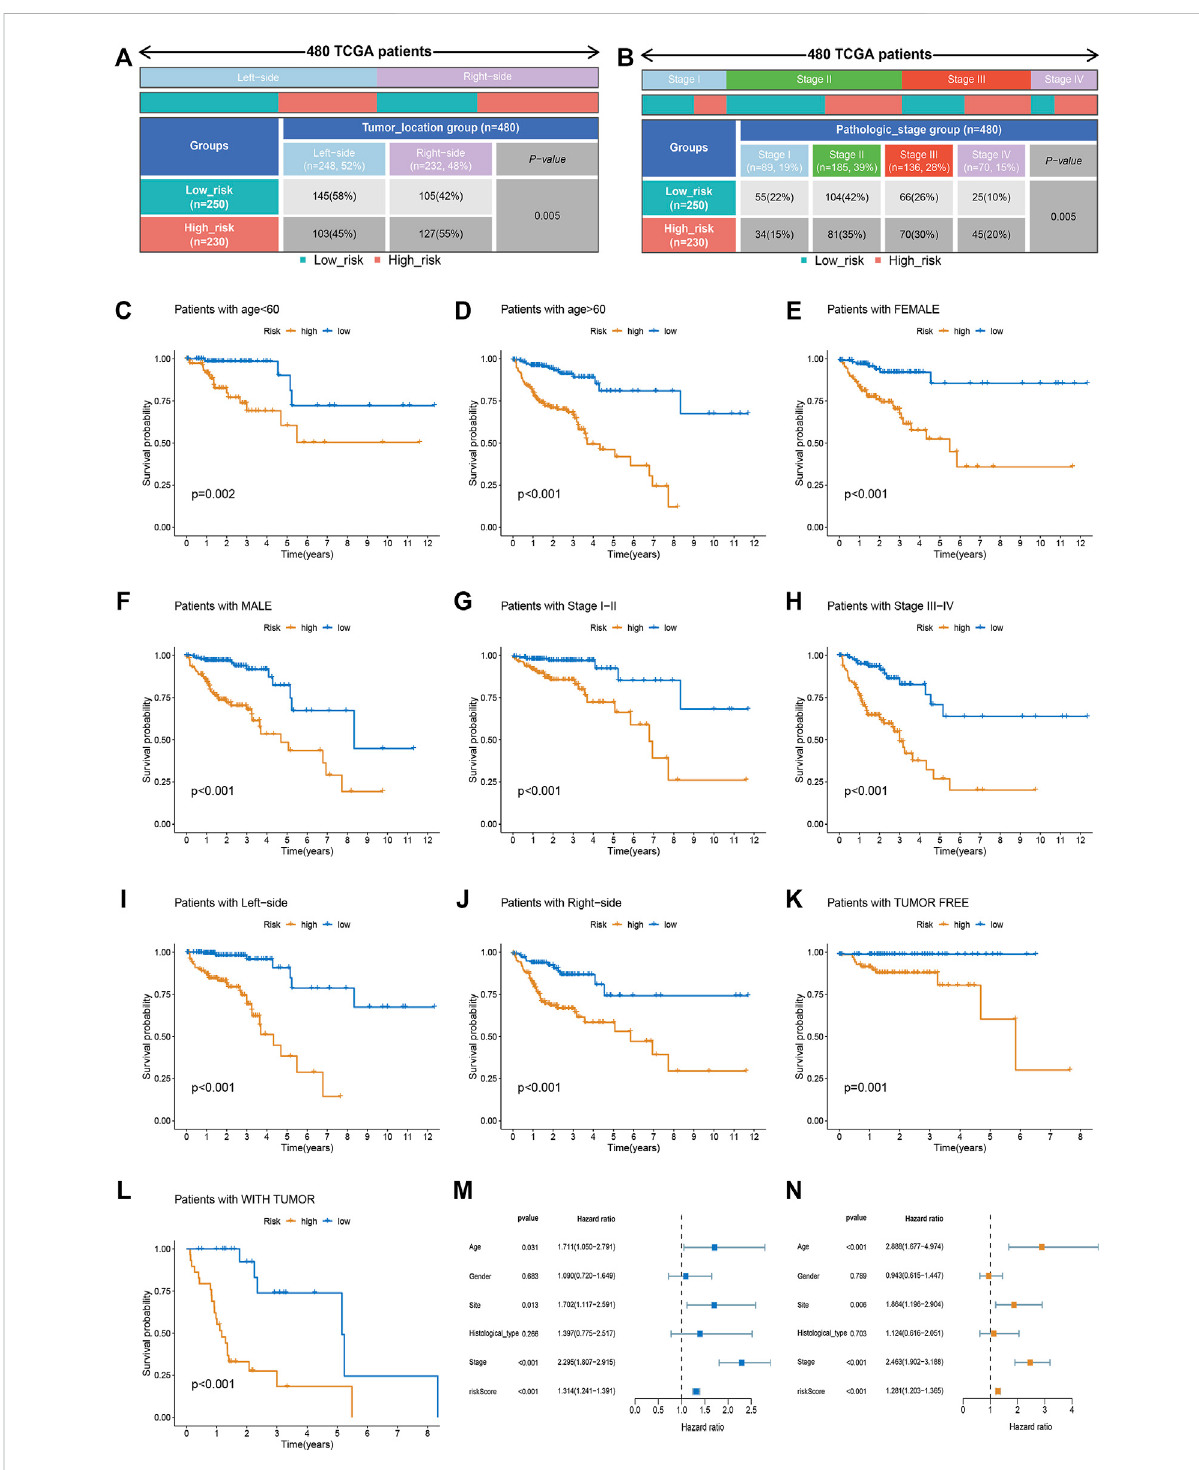
FIGURE 2 Clinical correlation analysis and strati fi cation analysis of the risk score. (A,B) The relationship between the risk score and tumor site and TNM stage. (C – L) The Kaplan-Meier survival curves were strati fi ed by different clinicopathological variants, including age, sex, tumor site, TNM stage, and tumorstatus. (M) TheclinicopathologicaltraitsandriskscorewereanalyzedbyunivariateCoxregressionwiththeOS. (N) MultivariateCoxregression analysis revealing clinicopathological traits and risk scores related to